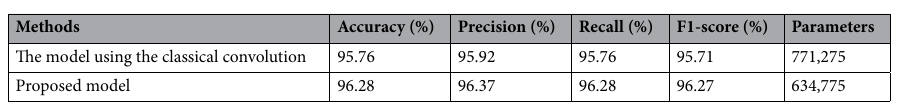
Table 8. Performance comparison of the proposed model with the model using classical convolutions on the PAMAP2 dataset.